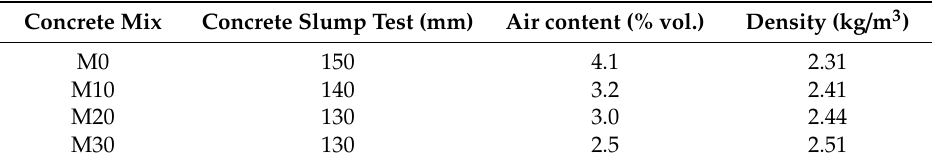
Table 4. Properties of concrete mixes with basalt dust